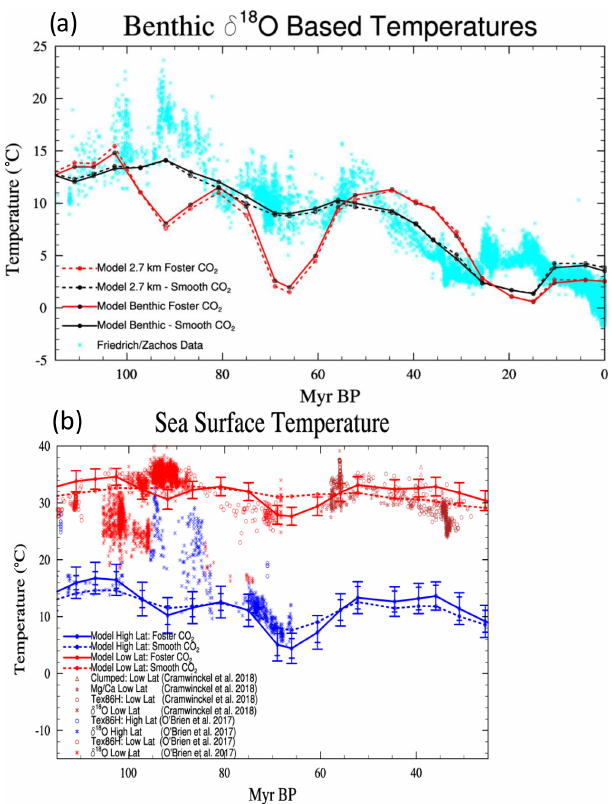
Figure 4. (a) Comparison of modelled deep ocean tempera- tures versus those from Zachos et al. (2008) and Friedrich et al. (2012) converted to temperature using the formulation in Hansen et al. (2013). The model temperatures are global averages over the bottom layer of the model but exclude shallow marine settings (less than 1000m). The dashed lines show the modelled global average ocean temperatures at the model layer centred at 2731m and (b) comparison of modelled sea surface temperatures with the compilations of O’Brien et al. (2017) and Cramwinckel et al. (2018). The data are a combination of Tex 86 , δ 18 O, Mg / Ca, and clumped isotope data. The model data show low-latitude tempera- tures (averaged from 10 ◦ S to 10 ◦ N) and high-latitude temperatures (averaged over 47.5 to 65 ◦ N and 47.5 to 65 ◦ S). The Foster CO 2 simulations also show a measure of the spatial variability. The large bars show the spatial standard deviation across the whole region, and the smaller bars show the average spatial standard deviation along longitudes within the region. Note that the ranges of both the x and y axes differ between panels (a) and (b)